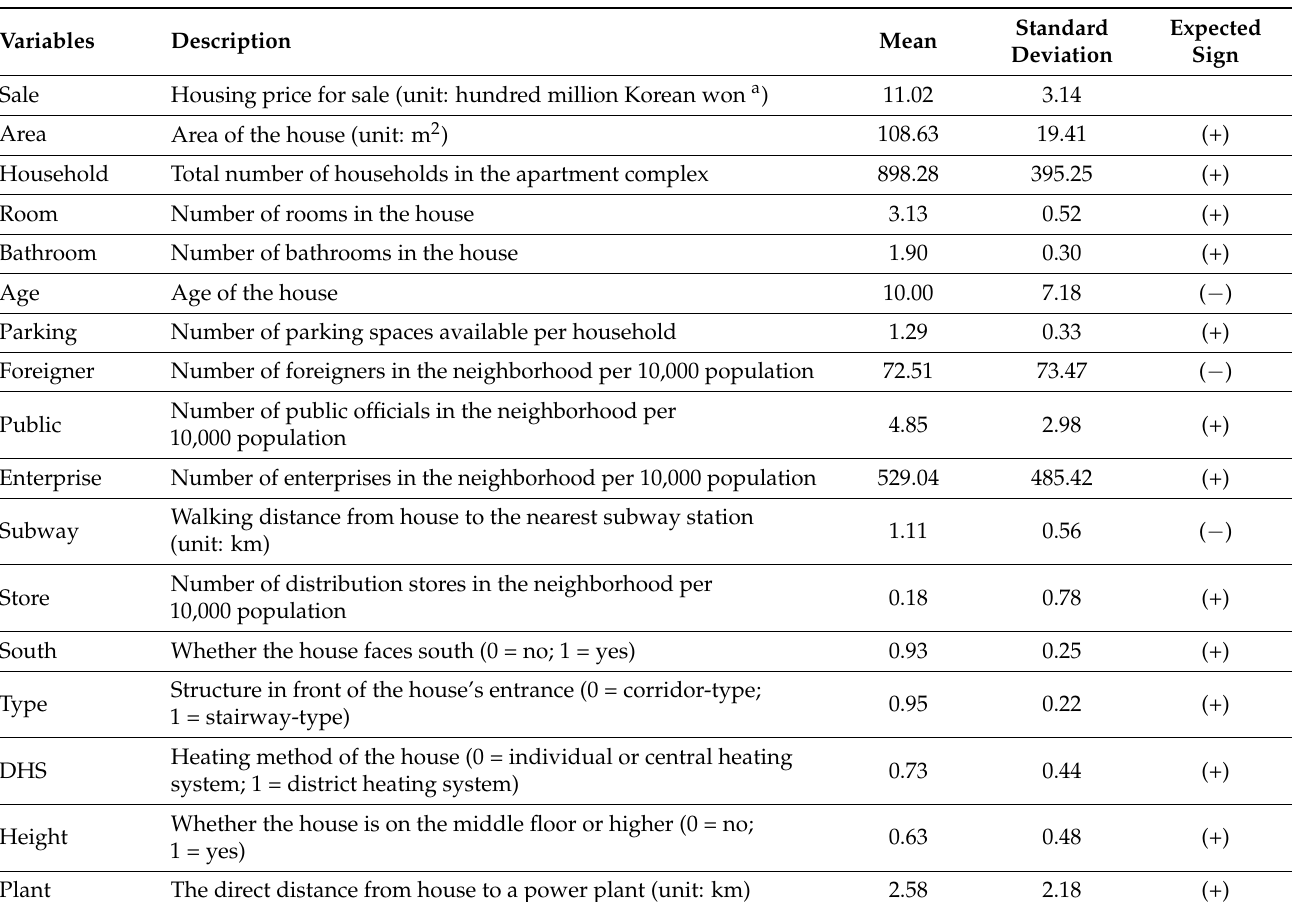
Table 1. Description of